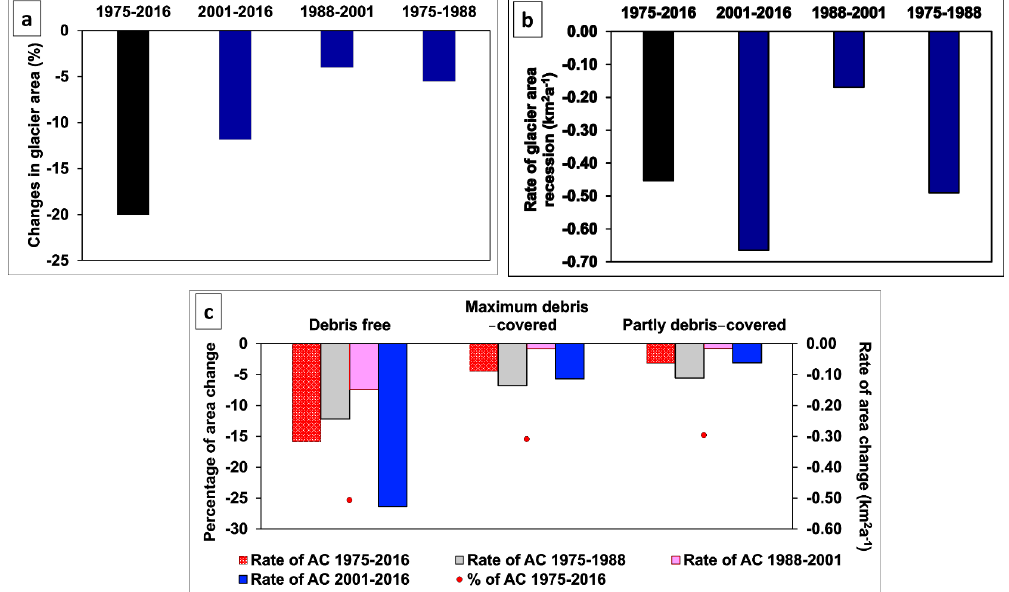
Table 4. Nature of glacier area change during the study period (1975–2016).